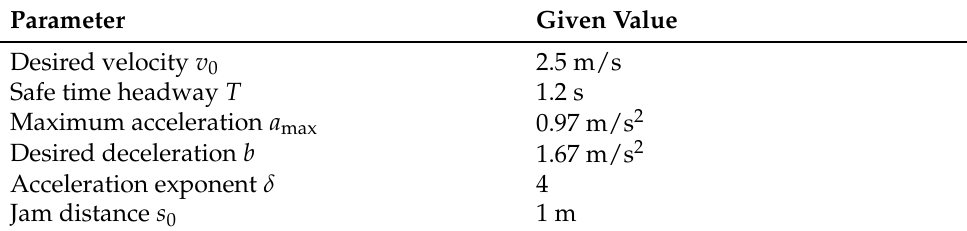
Table 1. Parameter values for the intelligent driver model